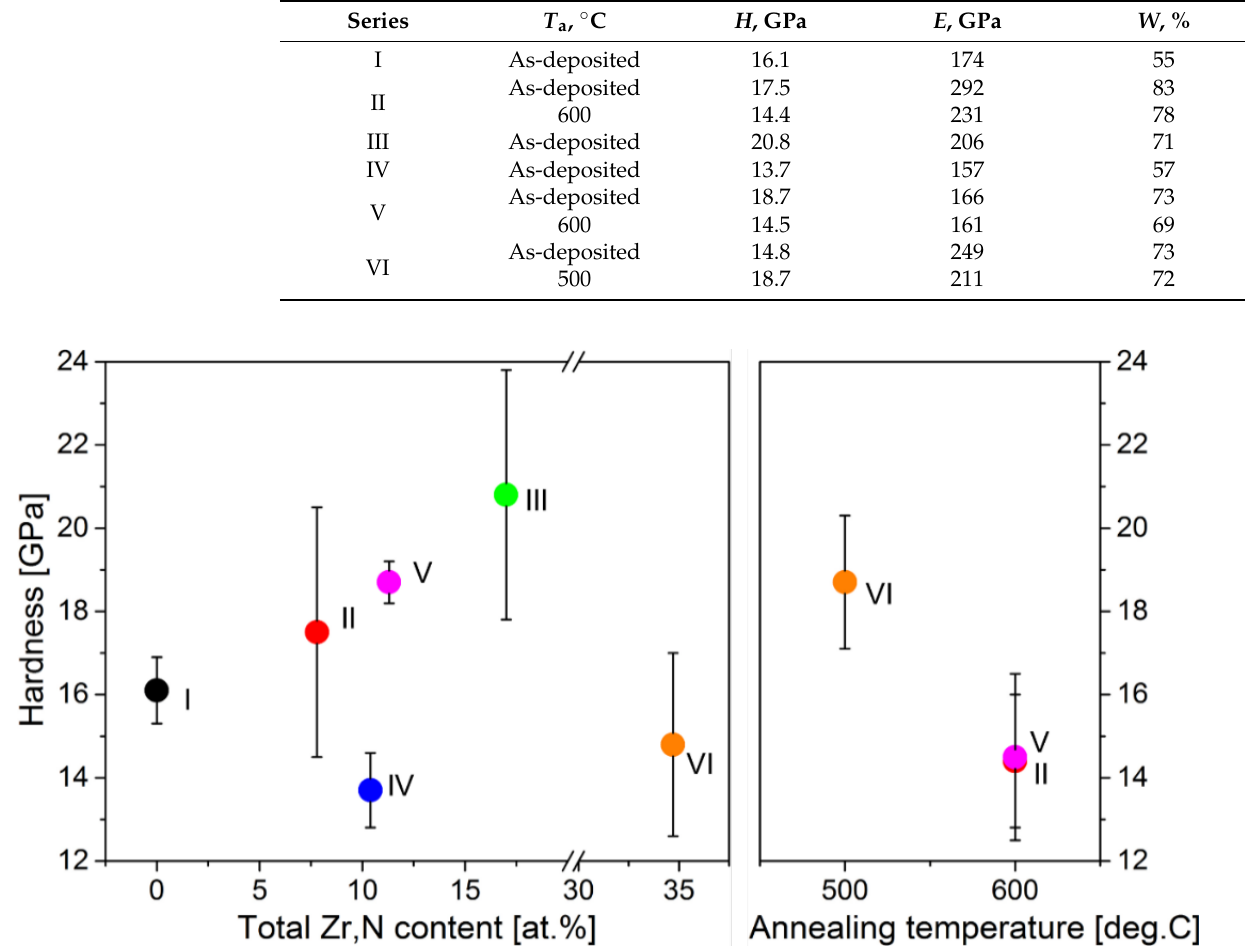
Figure 7. The influence of the total content of Zr and N in the films and the annealing temperature on the hardness of the films.